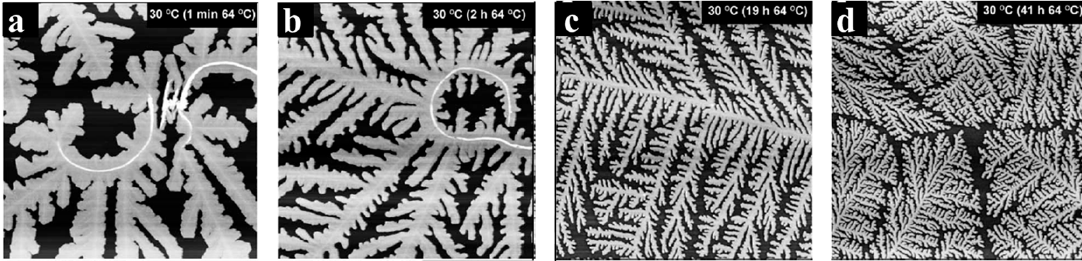
Figure 6. TP-AFM height images (10 μ m × 10 μ m) of PCL thin film (6 nm) isothermally crystallized at 30 °C after thermal treatment at 64 °C for: ( a ) 1 min; ( b ) 2 h; ( c ) 19 h; and ( d ) 41 h [51]. Image size: 10 × 10 μ m 2 . Copyright 2005. Reproduced with permission from Elsevier Ltd.